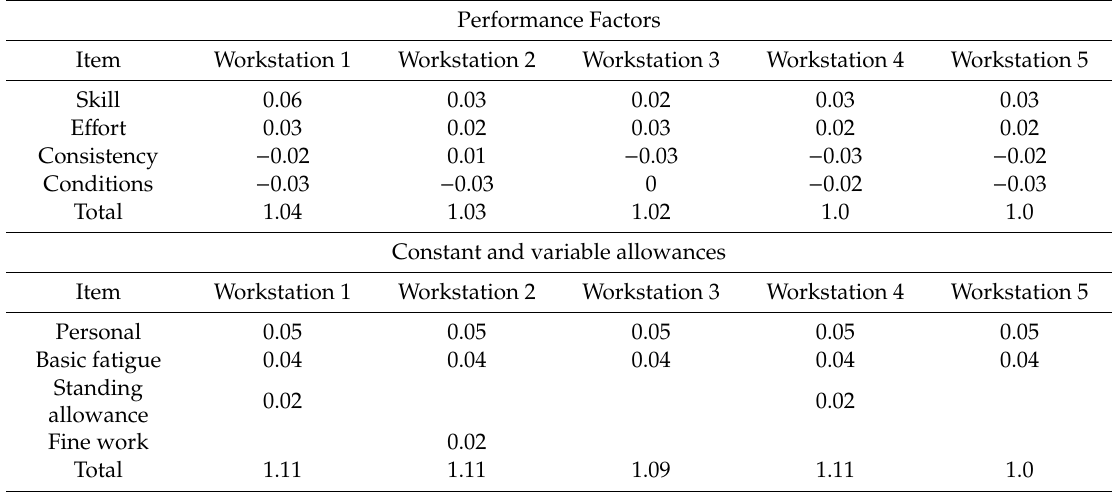
Table 2. Performance factors and allowances in original